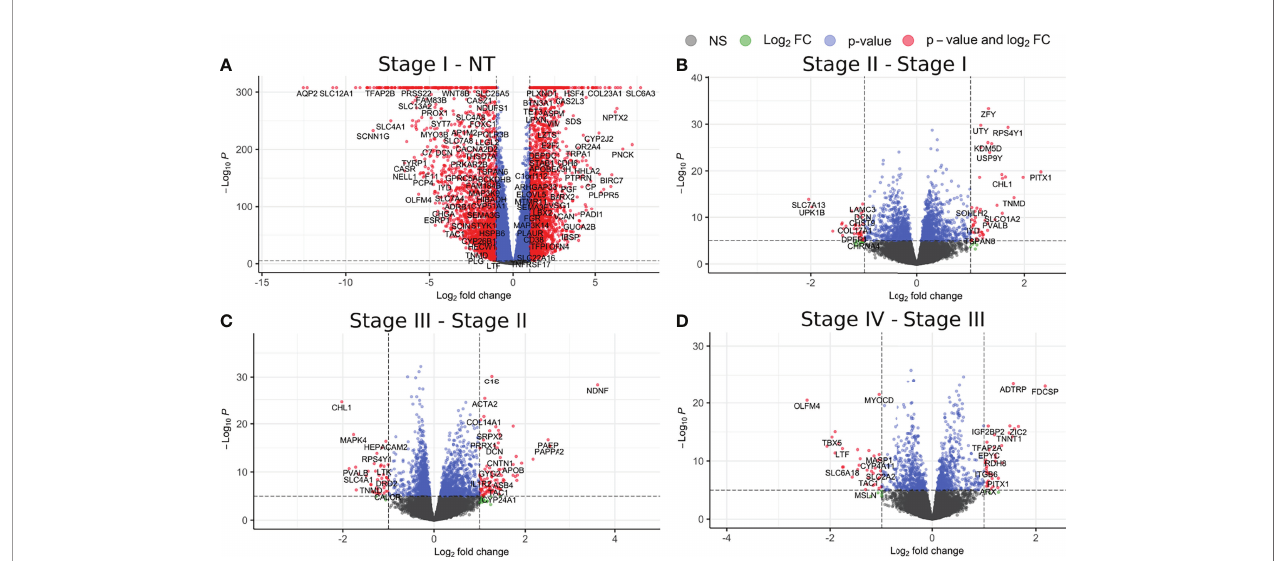
FIGURE 2 | Differentially expressed genes for each contiguous stage of ccRC. (A) Contrast between control and stage I; (B) stage I V, stage II; (C) stage II V, stage III; (D) stage III V, stage IV. Red circles represent genes with a |log 2 FC| >1 and a p -value < 1e-5; circles depicted in green take account for those genes with a |